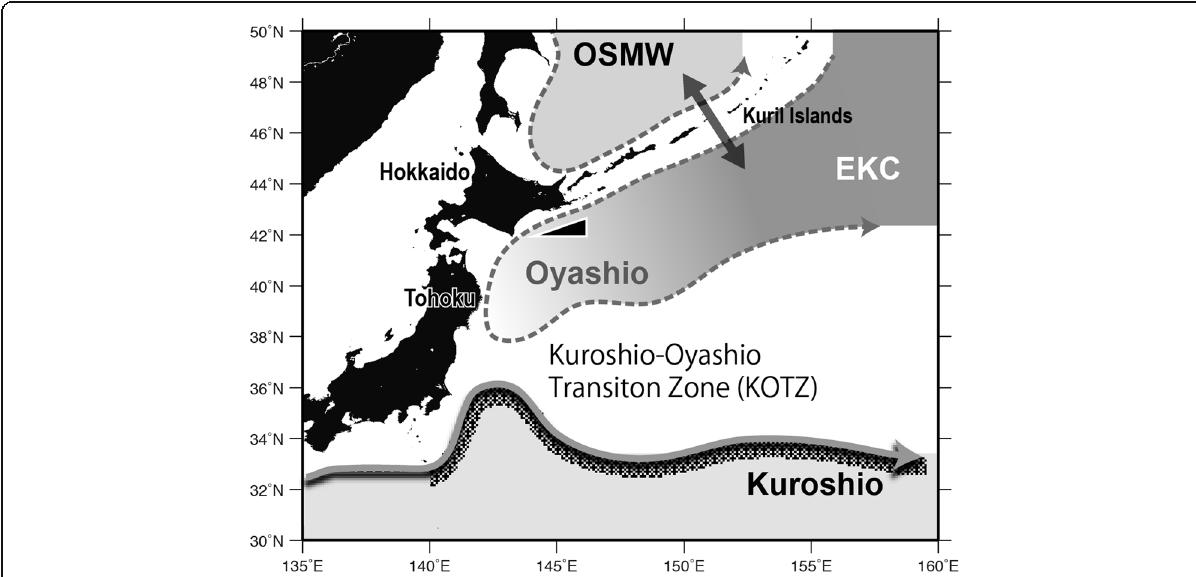
Fig. 1 Schematic diagram of the Kuroshio and Oyashio. Oyashio is a mixture of the East Kamchatka Current (EKC) and Okhotsk Sea Mode Water (OSMW) that outflows to the Pacific through the Kuril Straits. The black triangle represents the area where we picked up waters as the pure Oyashio water and the shaded area below the Kuroshio (gray arrow) represent the area where we picked up waters as the pure Kuroshio